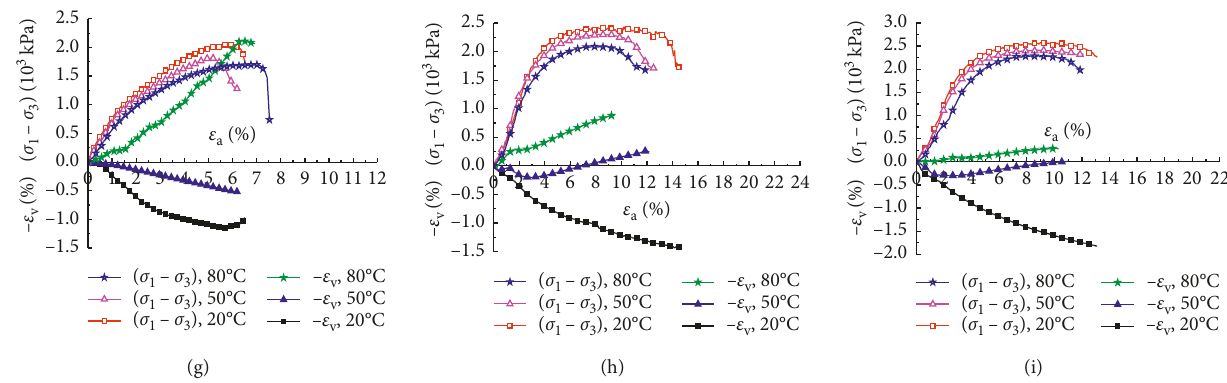
Figure 6: The relationship curves of ( σ confining pressures, and temperatures. (a) ρ � 2000 kPa. (d) ρ w � 5%, σ 3 � 1.8 g/cm 3 , w � 25%, σ 2000 kPa. (g) ρ d